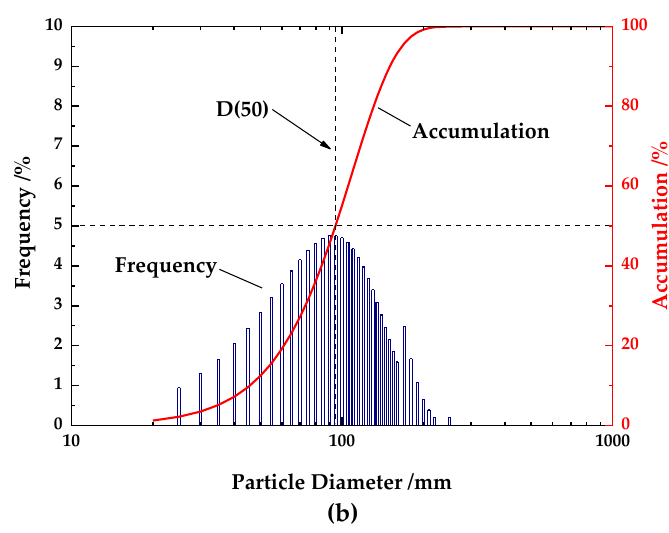
Figure 13. Droplet spectra of different PWM square wave duty ratios: ( a ) droplet spectrum with a duty ratio of 40%; ( b ) droplet spectrum with a duty ratio of 100%.